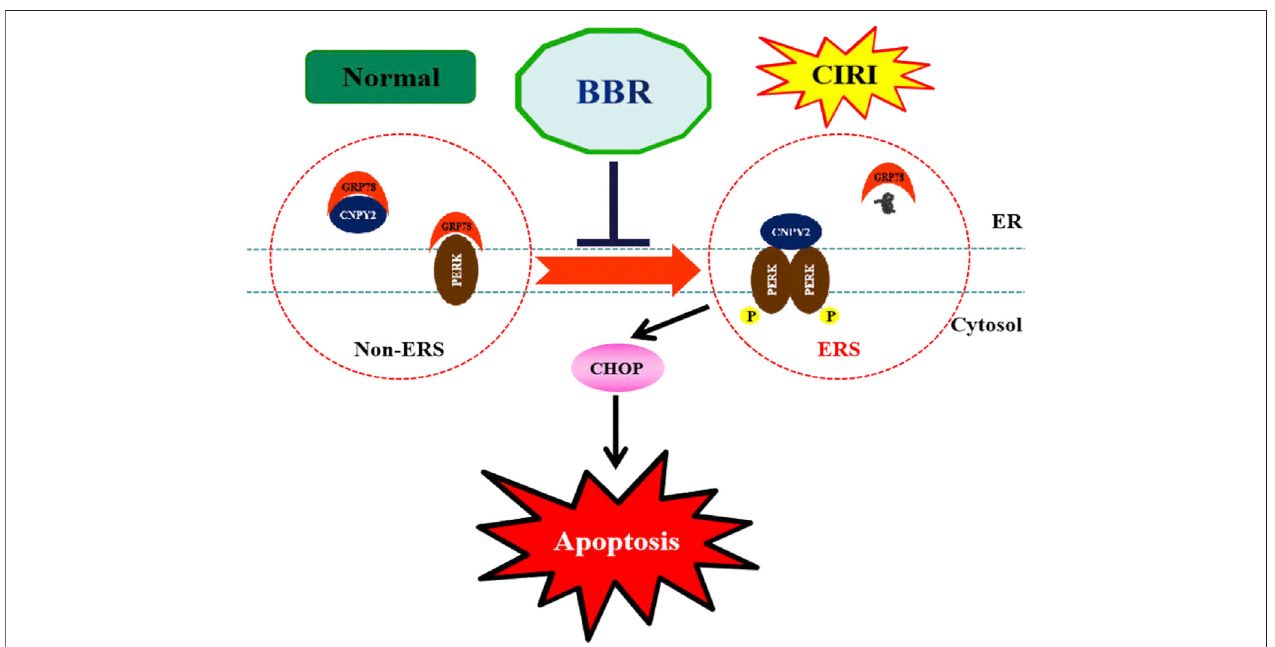
FIGURE 8 | BBR alleviates ERS after CIRI. Berberine signi fi cantly inhibited CIRI induced up-regulation of CNPY2, GRP78 and CHOP, hallmarks of ERS. BBR, Berberine;CIRI,cerebralischemia-reperfusioninjury;CNPY2,canopyFGFsignalingregulator 2;GRP78:glucose-regulated protein 78; CHOP: C/EBPhomologous protein.